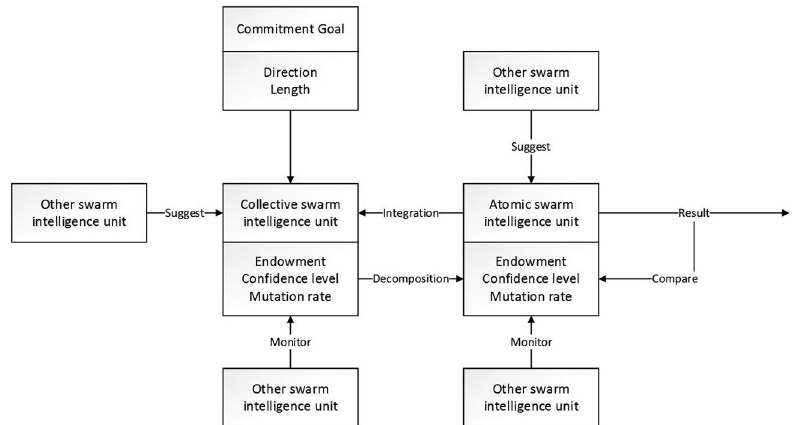
Figure 1. Simulation